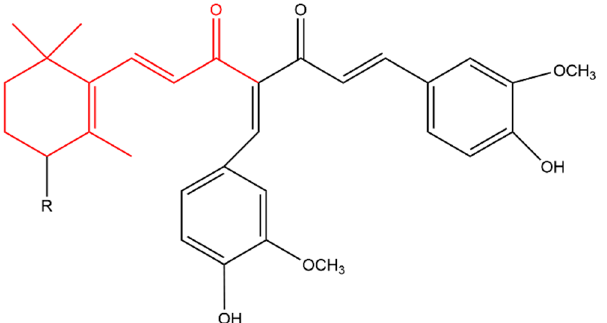
Figure 10. (Compound a ). R = H; [(1 E ,6 E )-4-(( Z )-4-hydroxy-3-methoxybenzylidene)-1-(4-hydroxy-3-methoxyphenyl)-7-(2,6,6-trimethylcyclohex-1-en-1-yl)hepta-1,6-diene-3,5-dione] (compound b ). R = OH; [(1 E ,6 E